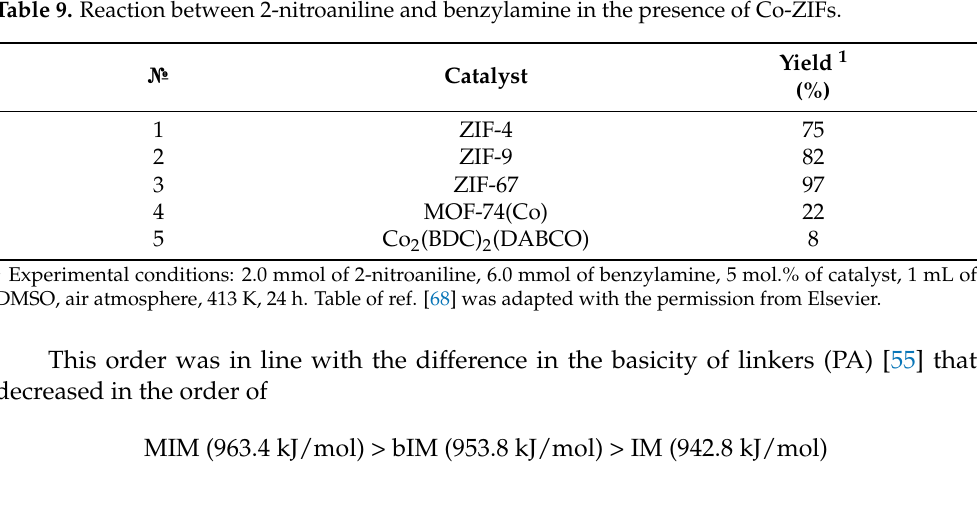
Table 9. Reaction between 2-nitroaniline and benzylamine in the presence of Co-ZIFs. № Catalyst